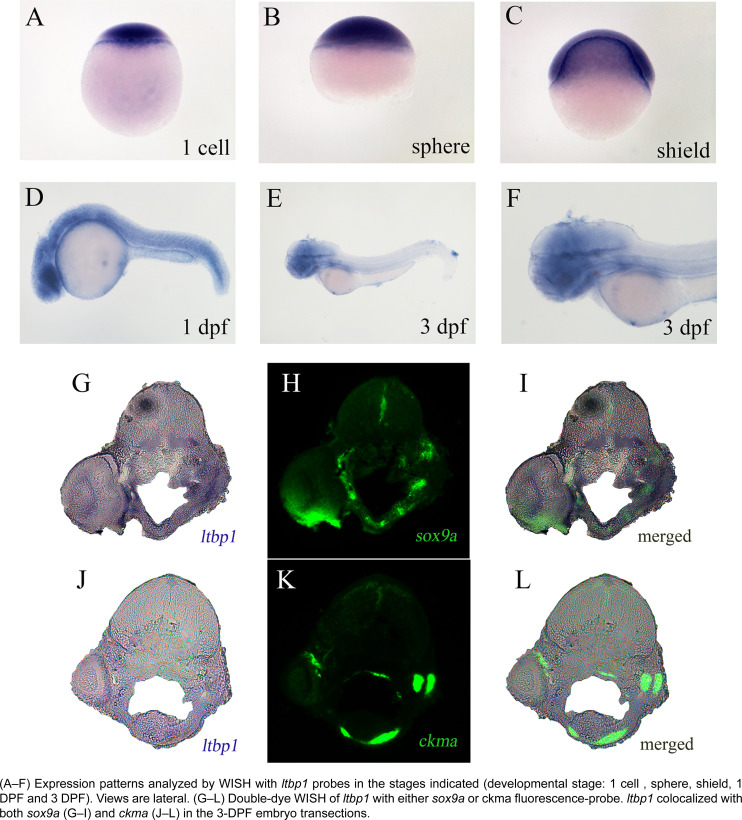
Expression patterns of ltbp1